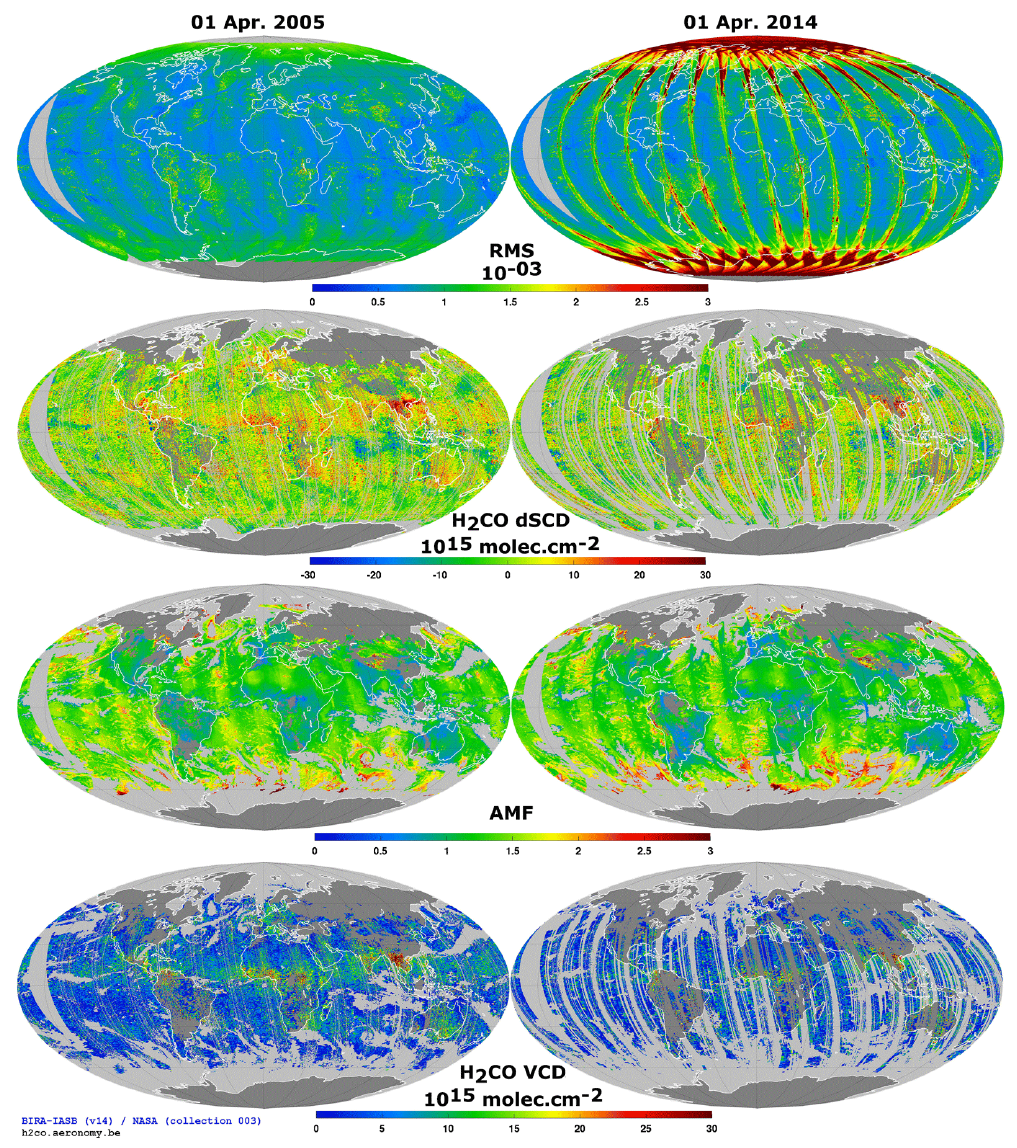
Figure 6. Intermediate retrieval quantities of the H 2 CO retrieval algorithm illustrated with OMI on 1 April 2005 (first column) and 1 April 2014 (second column). The first line shows the fit residuals, while lines 2 to 4 show respectively the H 2 CO reference sector corrected slant columns, the air mass factors and the vertical